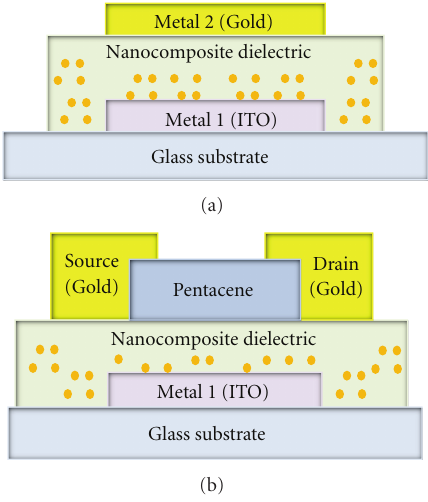
Figure 1: (a) The MIM structure of TiO 2 –PVP nanocomposite gate dielectric. (b) Configuration of “Bottom Gate” and “Top Contact” structure of an OTFT with the nanocomposite gate